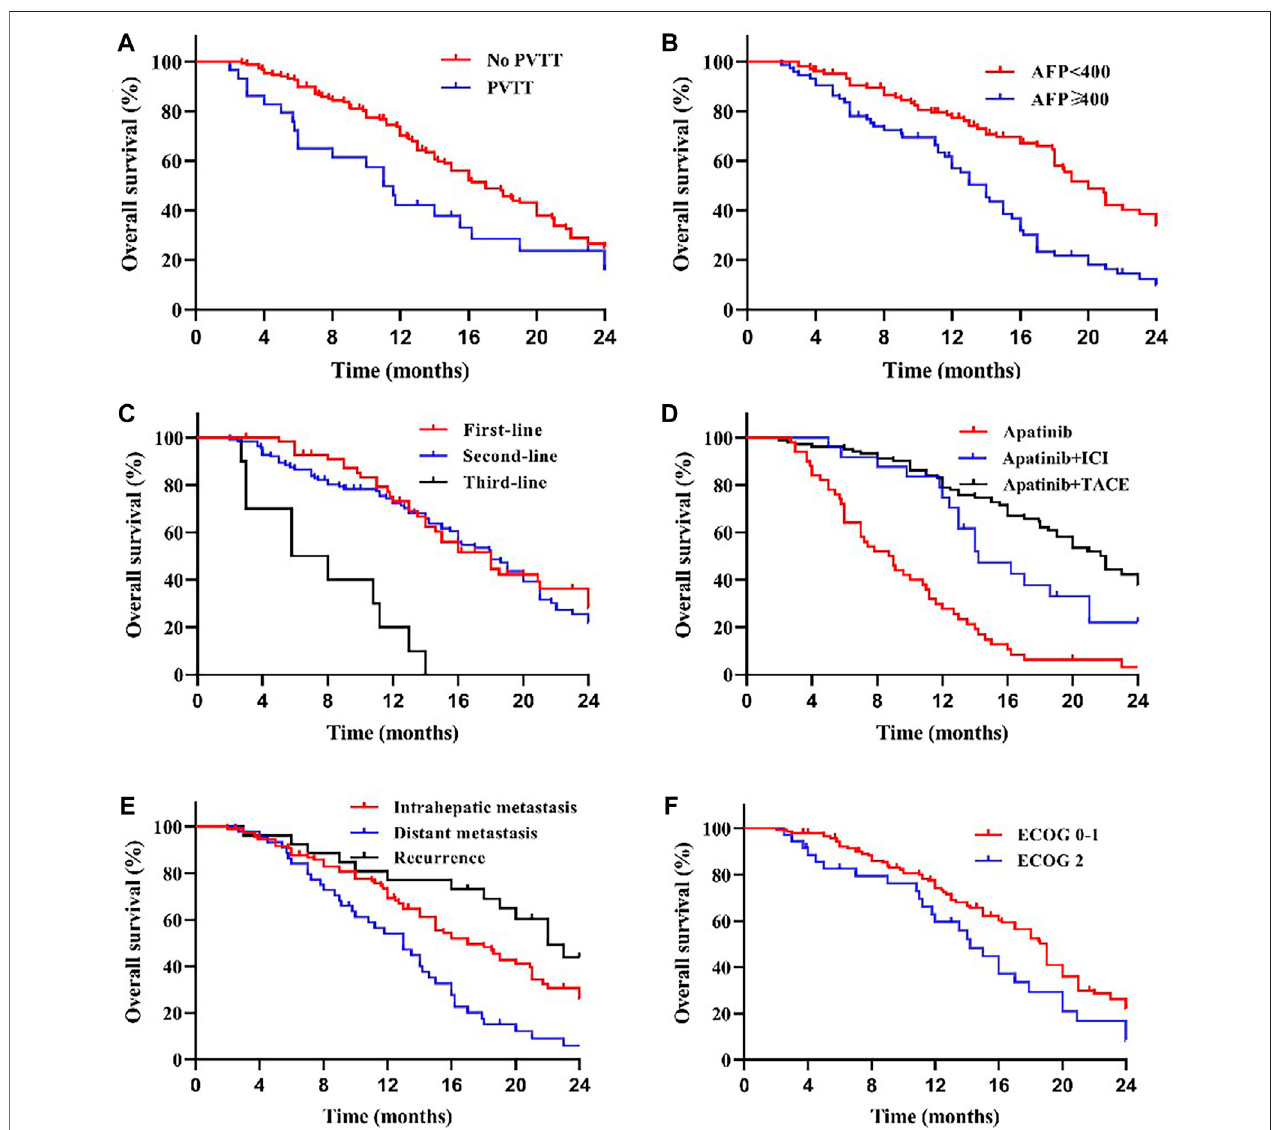
FIGURE3| Kaplan – MeiercurvesshowingtheOSofpatientsbyunivariateanalysiswithadvancedHCCtreatedwithapatinib,includingsigni fi cantlydifferentresults. (A) ComparisonofOSbetweenpatientswithPVTT(present)andwithoutPVTT(absent)beforetheapatinibtherapy.ThemOSwas11.0months(95%CI:8.90 – 13.10)for treatment with PVTT versus 16.0 months (95% CI: 13.42 – 18.58) for treatment without PVTT ( p < 0.05). (B) Comparison of OS between patients with AFP < 400 ng/ml and AFP ≥ 400 ng/ml before the apatinib therapy. The mOS was 19.0 months (95% CI: 16.74 – 21.26) for patients with AFP < 400 ng/ml versus 12.0 months (95% CI: 10.72 – 13.28) for patients with AFP ≥ 400 ng/ml ( p < 0.001). (C) The mOS was signi fi cantly longer in fi rst-line (16.0 months, 95% CI: 12.61 – 19.39) and second-line (17.0 months, 95% CI: 14.33 – 19.67) treatment patients than in third-line (5.8 months, 95% CI: 0.64 – 10.97) treatment ( p < 0.001). (D) The mOS of apatinib combined with TACE (20.0 months, 95% CI: 17.13 – 22.88) and immunotherapy (14.0 months, 95% CI: 12.58 – 15.42) was longer than that of apatinib monotherapy (8.7 months, 95%CI:6.51 – 10.90)( p < 0.001). (E) ThemOSwasshorterinpatientswithdistant(13.0 months,95%CI:10.09 – 15.91)andintrahepaticmetastases(16.0 months,95% CI:12.54 – 19.46)thaninpatientswithpostoperativerecurrence(24.0 months,95%CI:18.54 – 29.46)( p < 0.05),comparedwithdifferentstatesoftumorprogression. (F) Comparison of OS between patients with ECOG scores 0 – 1 and 2 before the apatinib therapy. The mOS was 16.2 months (95% CI: 13.33 – 19.07) for patients with ECOG scores 0 – 1 versus 13.5 months (95% CI: 10.39 – 16.61) for patients with ECOG scores 2 ( p <